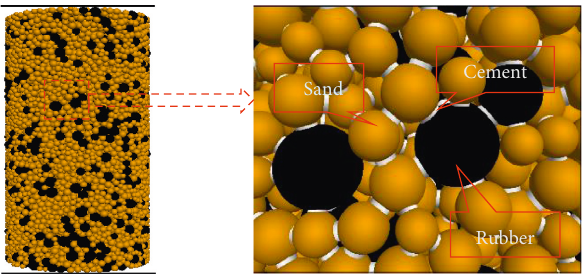
Figure 7: The numerical loading scheme and mesoscopic interface of samples.